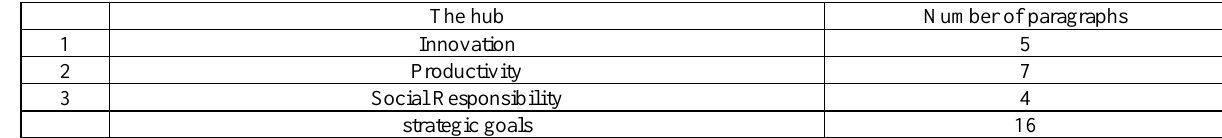
Table 9. Themes of the strategic goals and the number of its paragraphs The hub